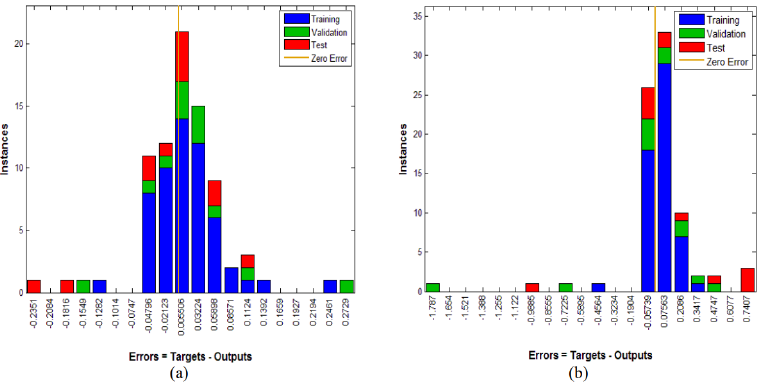
Figure 4. ( a ) Error histogram of ANN model for flat surface; ( b ) Error histogram of ANN model for cylindrical surface. Figure 5a,b o ff er the mean square error graphs of SFC. To be more speci fi c, Figure 5a o ff ers the MSE for SFC at the fl at surface while Figure 5b o ff ers the MSE for SFC at the cylindrical surface. Both fi gures support that the learning stages of ANN-I and ANN-II are completed in a perfect way. MSE values are plo tt ed for each of the 80 data samples. The nearness of MSE values towards zero re fl ects the fewer errors while training the ANN models to predict the SFC. The average MSE for the case of a fl at surface is 0.0051666569 while, for the case of a cylindrical surface, it is recorded as 0.101813. Which is quite low, hence, the training of the neural networking model is perfect to predict the values of SFC at both fl at and cylindrical surfaces.